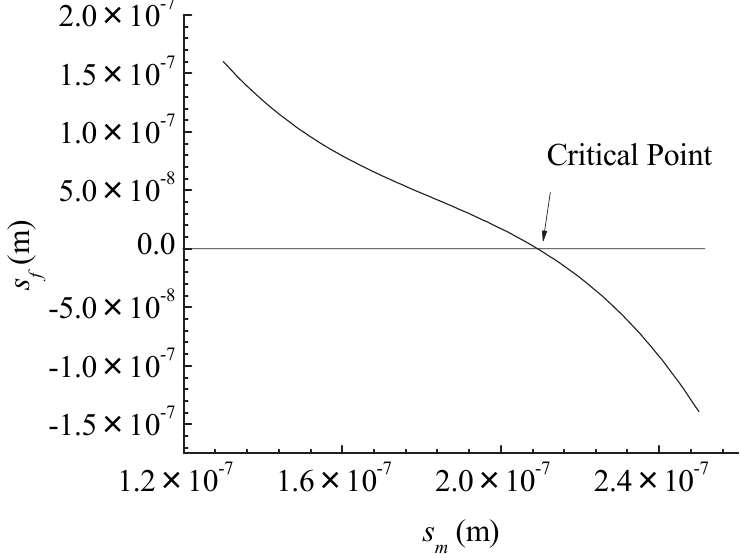
Fig. 4 Relationship between s